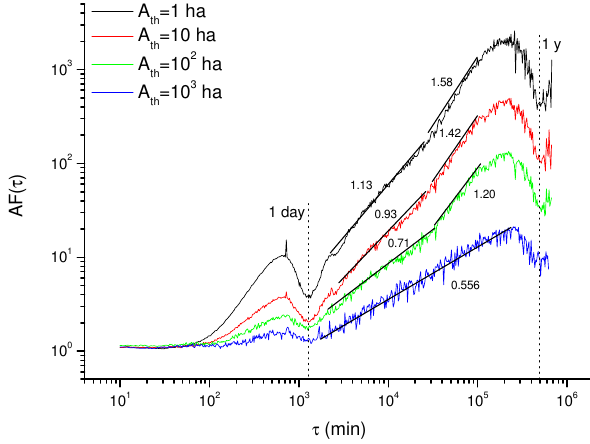
Fig. 3. Log-log plot of the Allan Factor (AF) as a function of the timescale τ , for the Portuguese fire series, considering fire events Figure 3. Log-log plot of the Allan Factor ( AF ) as a function of the timescale τ , for the 2 with burnt area ( A ) above or equal increasing thresholds ( A th ) of 1, Portuguese fire series, considering fire events with burned area ( A ) above or equal increasing 3 10, 10 2 and 10 3 ha, registered in the 1980–2005 period. thresholds ( A th ) of 1, 10, 10 2 and 10 3 ha, registered in the 1980-2005 period. 4